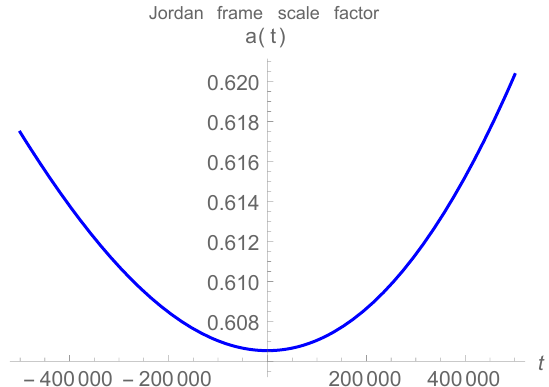
Figure 5. Time evolution of the scale factor in the Jordan frame for a bounce in vacuum background in exponential gravity found with the initial conditions φ ( 0 ) = √ ˜ H ( 0 ) = κ /6 φ (cid:48) ( 0 )